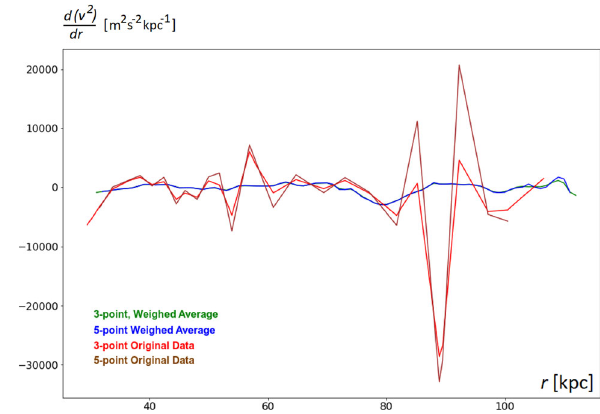
Fig. 1 First radial derivatives of orbital speed squared d v 2 using the three-point scheme for the calculation of derivatives (19) and the five-point scheme for the calculation of derivatives (20), with smoothing (referred to as weighted average) and without smoothing (referred to as original data)